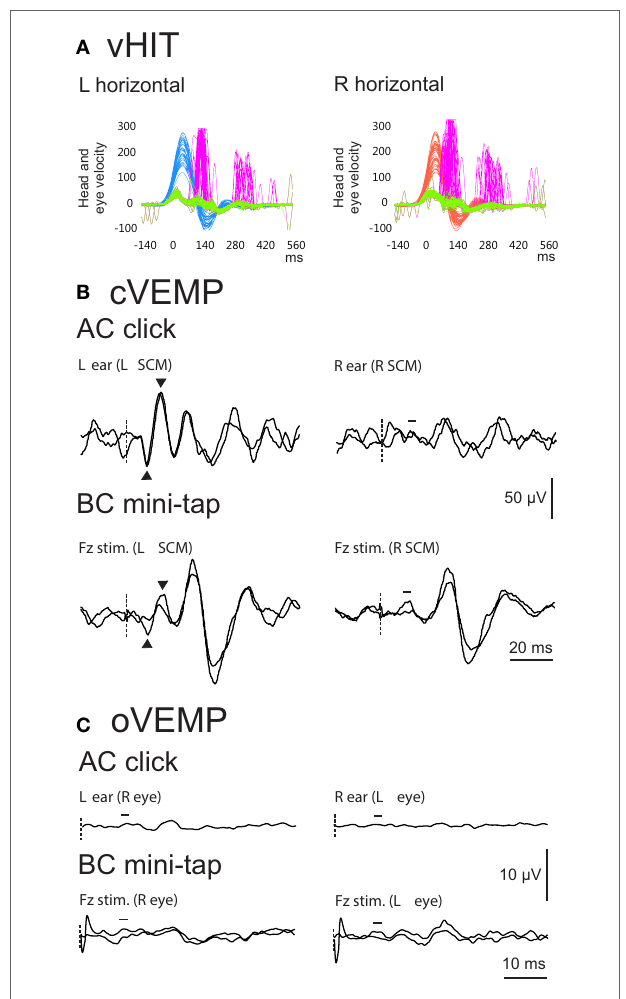
FiGURe 1 | Example vHIT (A) , cervical vestibular evoked myogenic potential (cVEMP) (B) and ocular VEMP (oVEMP) (C) results from a 54-year-old male patient with idiopathic bilateral vestibulopathy (BVP). For cVEMPs and oVEMPs, stimulus onset is indicated by the dashed line. vHIT results show reduced horizontal vestibulo-ocular reflex (VOR) gain [shown by the gap between the green (eye) and blue (head) traces on the left, and green and red traces on the right] and the presence of catch-up saccades (purple traces) on both sides. VOR gain on the left was 0.39 and on the right was 0.17, indicating that the patient met the test criteria for a diagnosis of BVP (gain less than 0.6) (6). cVEMPs evoked by air-conducted (AC) sound were clearly present on the left but absent on the right. cVEMPs evoked by bone-conducted (BC) mini-taps were present on one trial on the left only but were not readily reproducible. oVEMPs evoked by both AC and BC stimulation were absent bilaterally. The results in this patient highlight the mixed results often seen with VEMP testing in